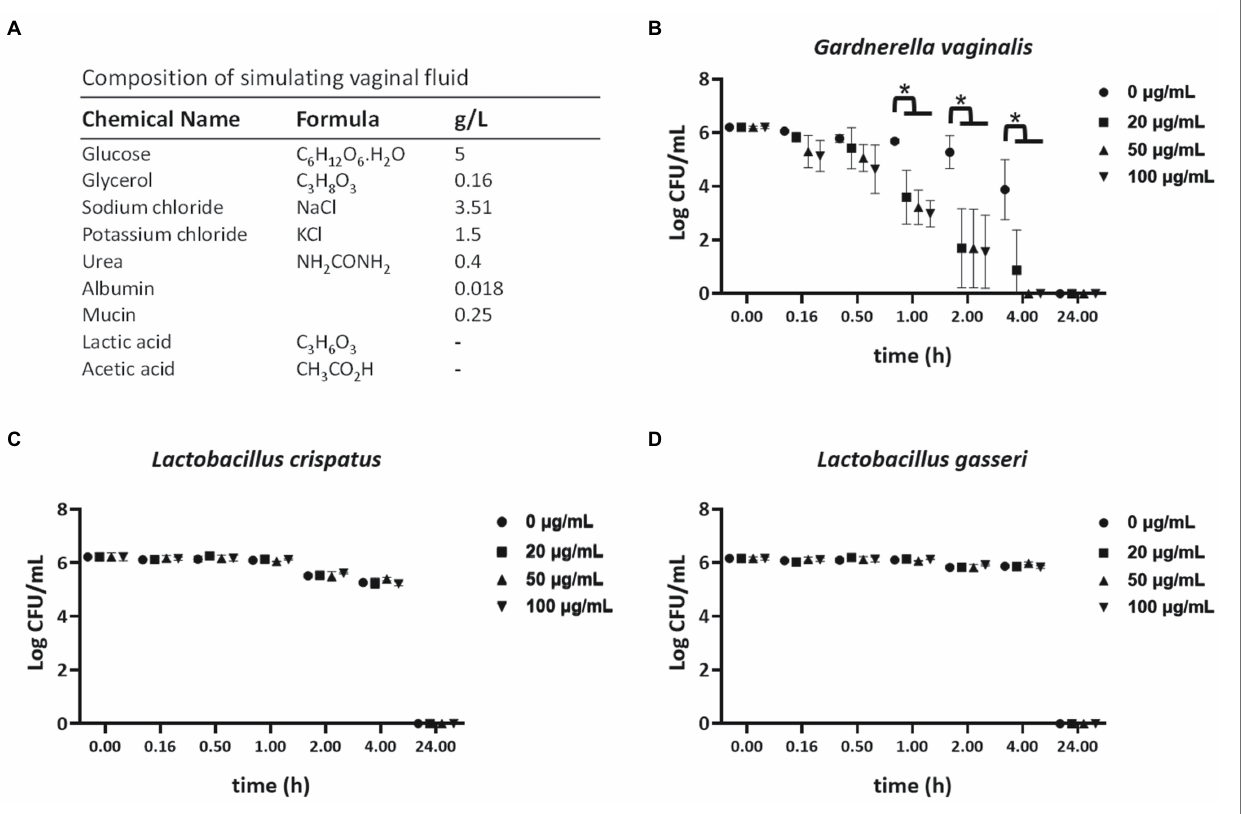
FIGURE 1 | Selective bactericidal activity of TP4 in vaginal fluid simulant (VFS). (A) VFS composition. ( − ): This formula of VFS does not include lactic acid and acetic acid in order to maintain a high survival rate of Gardnerella vaginalis . Viability of G. vaginalis (B) , Lactobacillus crispatus (C) , and Lactobacillus gasseri (D) in VFS after treatment with various TP4 concentrations (0, 20, 50, and 100 μ g/ml), as determined by colony-forming unit (CFU). All values represent the mean ± SD of three individual experiments. * p < 0.05 compared to CFU/ml from bacteria in VFS TP4-free control, determined by one-way